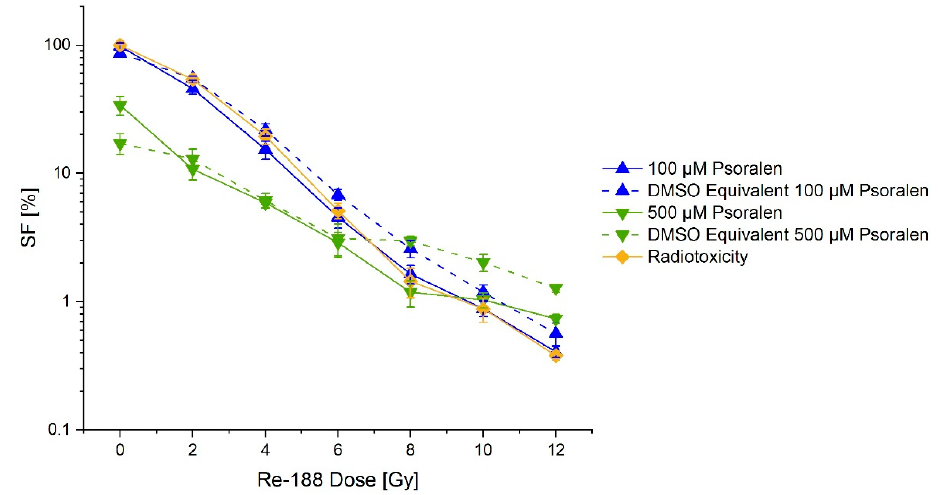
Figure 11. Concentration–effect relation for a combination of psoralen and Re-188 on the survival (SF) of FaDu cells (mere radiotoxicity is additionally shown). No significant difference between mere radiotoxicity and adding of psoralen was visible. The error bars show the SD pooled .